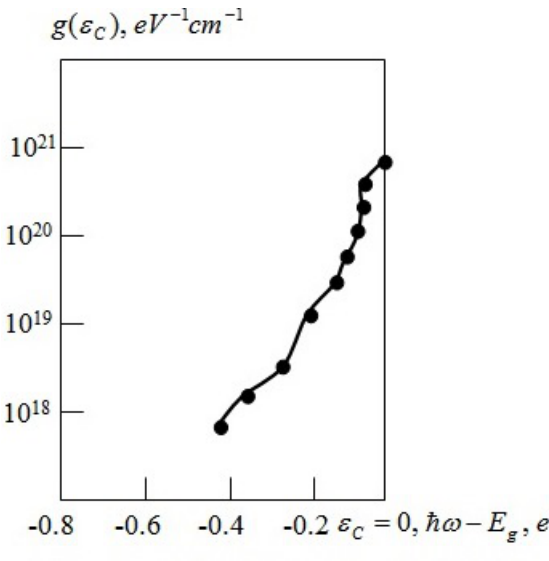
Fig. 3. The distribution of the density of electronic states in the tail of the conduction band of a hard alloy of amorphous sulfur selenium, calculated from formula (20) using the values of the exponential absorption spectrum shown in Fig.